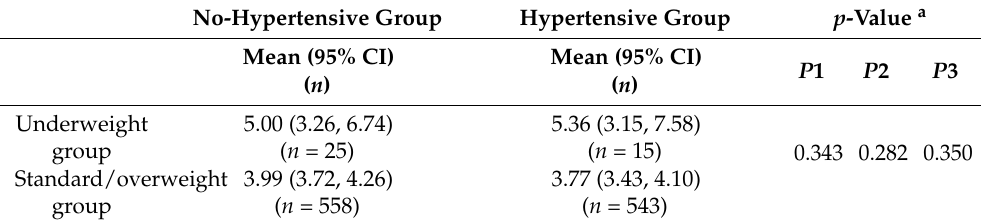
Table 4. Interactions between body size and hypertension on GDS in males.